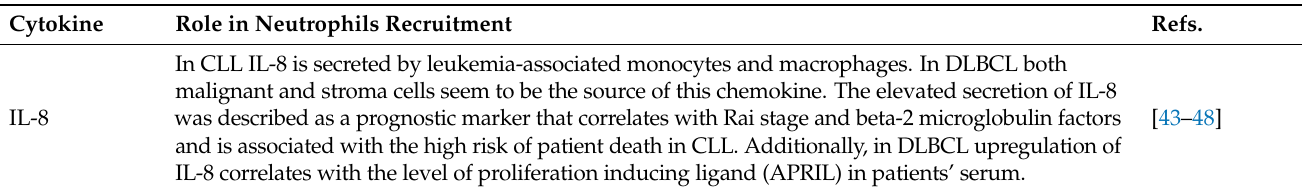
Table 1. Cytokines and receptors secreted in the microenvironment of leukemia and/or lymphoma that may be responsible for neutrophils’